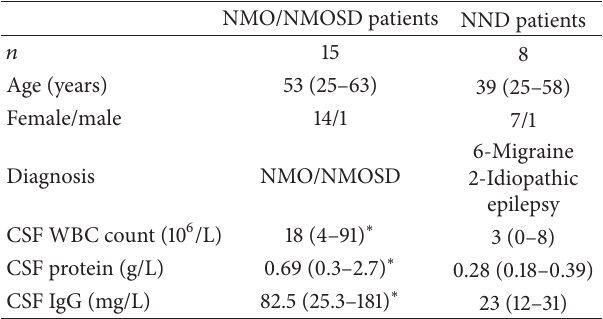
Table 2: The demographic and clinical features of NMO/NMOSD and NND patients who received a lumbar puncture.